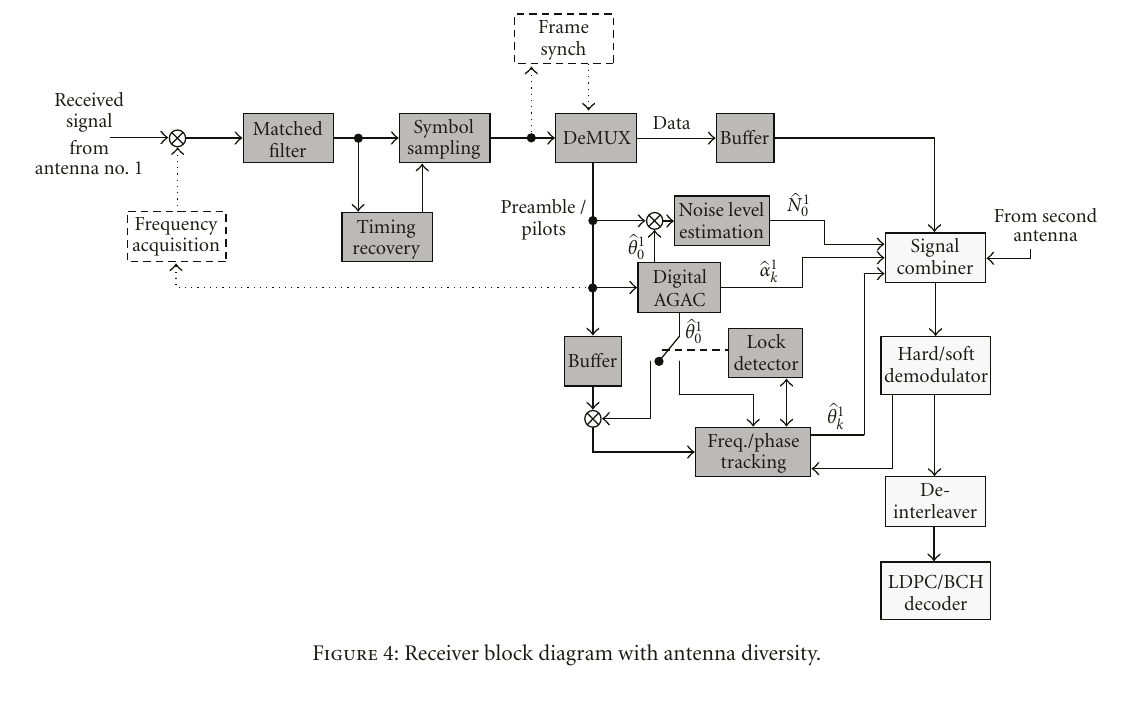
Figure 4: Receiver block diagram with antenna diversity.